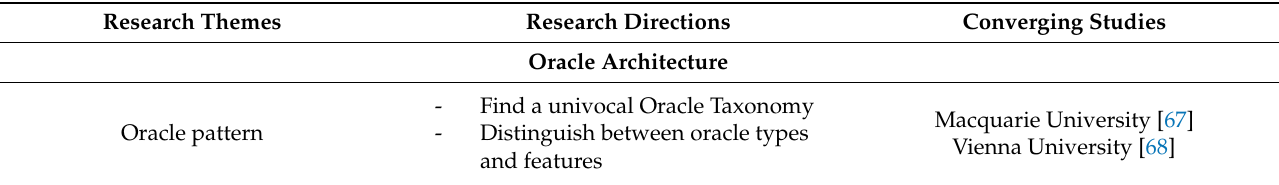
Table 12. Oracle theory: Themes, directions, and converging